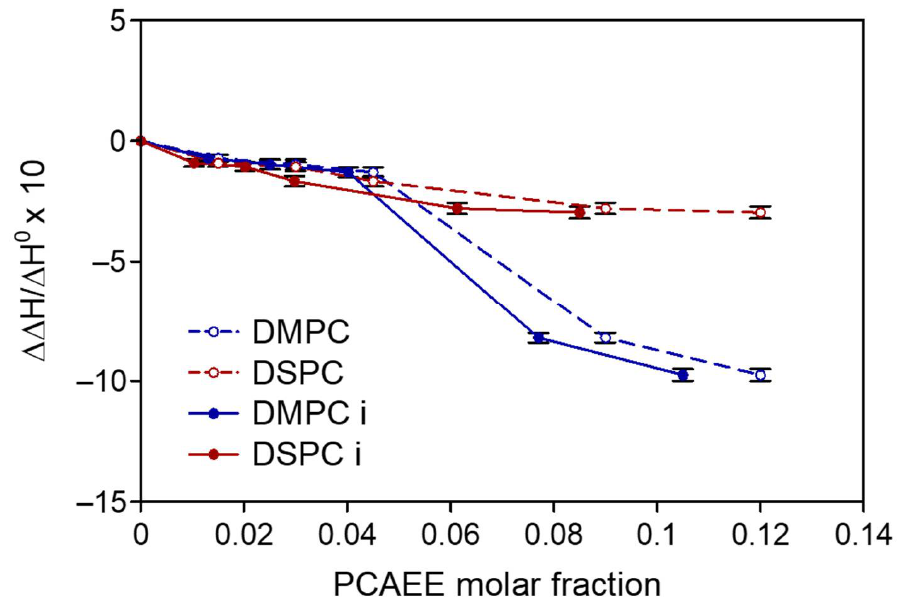
Figure 3. Enthalpy variation as ∆∆ H/ ∆ H 0 ( ∆∆ H = ∆ H − ∆ H 0 ; where ∆ H is the enthalpy variation of MLV with PCAEE, and ∆ H 0 is the enthalpy variation of MLV without PCAEE of MLV as a function of the molar fraction of PCAEE. The dotted lines refer to the data obtained from the calorimetric curves. The continuous lines refer to the effect due to the real amount of PCAEE present in the MLV.